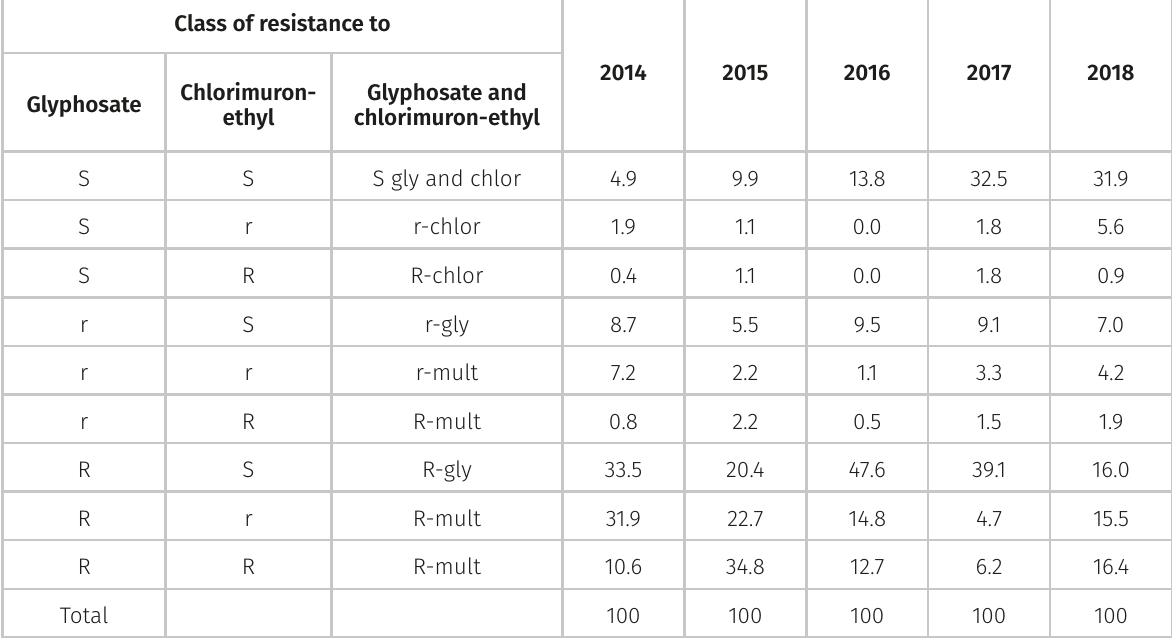
Table III. Frequency (%) of Conyza spp. populations with multiple resistance to glyphosate and chlorimuron-ethyl in